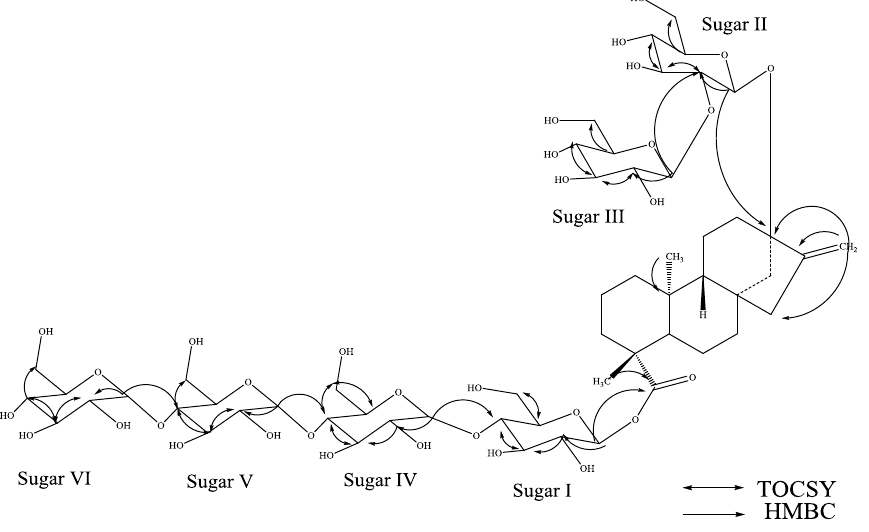
Figure 3. Key COSY and HMBC correlations of 2